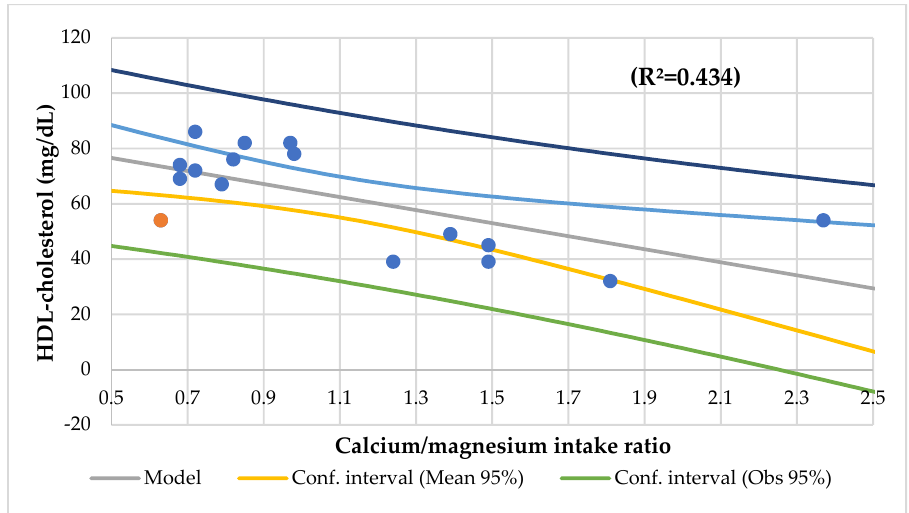
Figure 8. Regression HDL-cholesterol (mg/dL) by calcium/magnesium intake ratio.